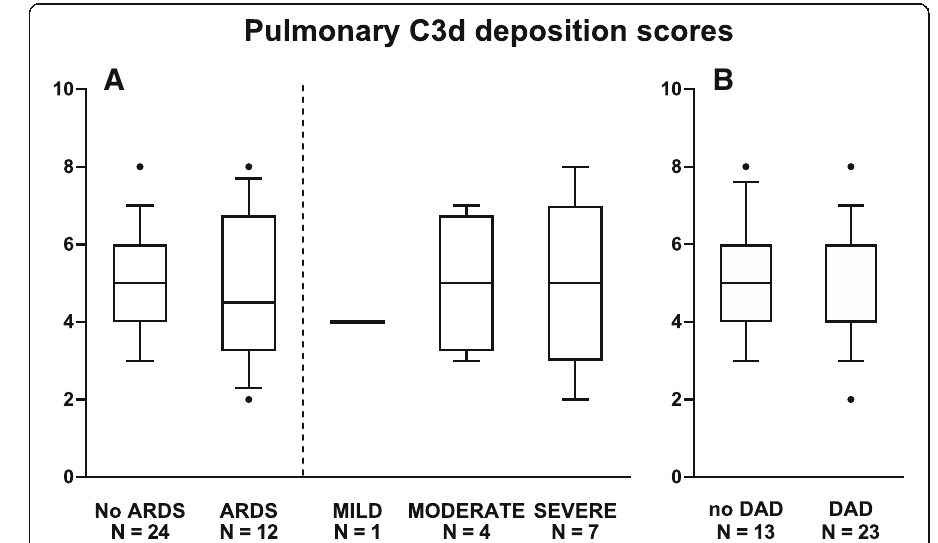
Fig. 2 a Pulmonary C3d deposition scores in patients without ARDS compared to patients with ARDS and subdivided into ARDS severity. b C3d deposition in the lung tissue of patients with and without DAD. Boxplots and whiskers are 25 – 75% and 10 – 90%; the dots represent